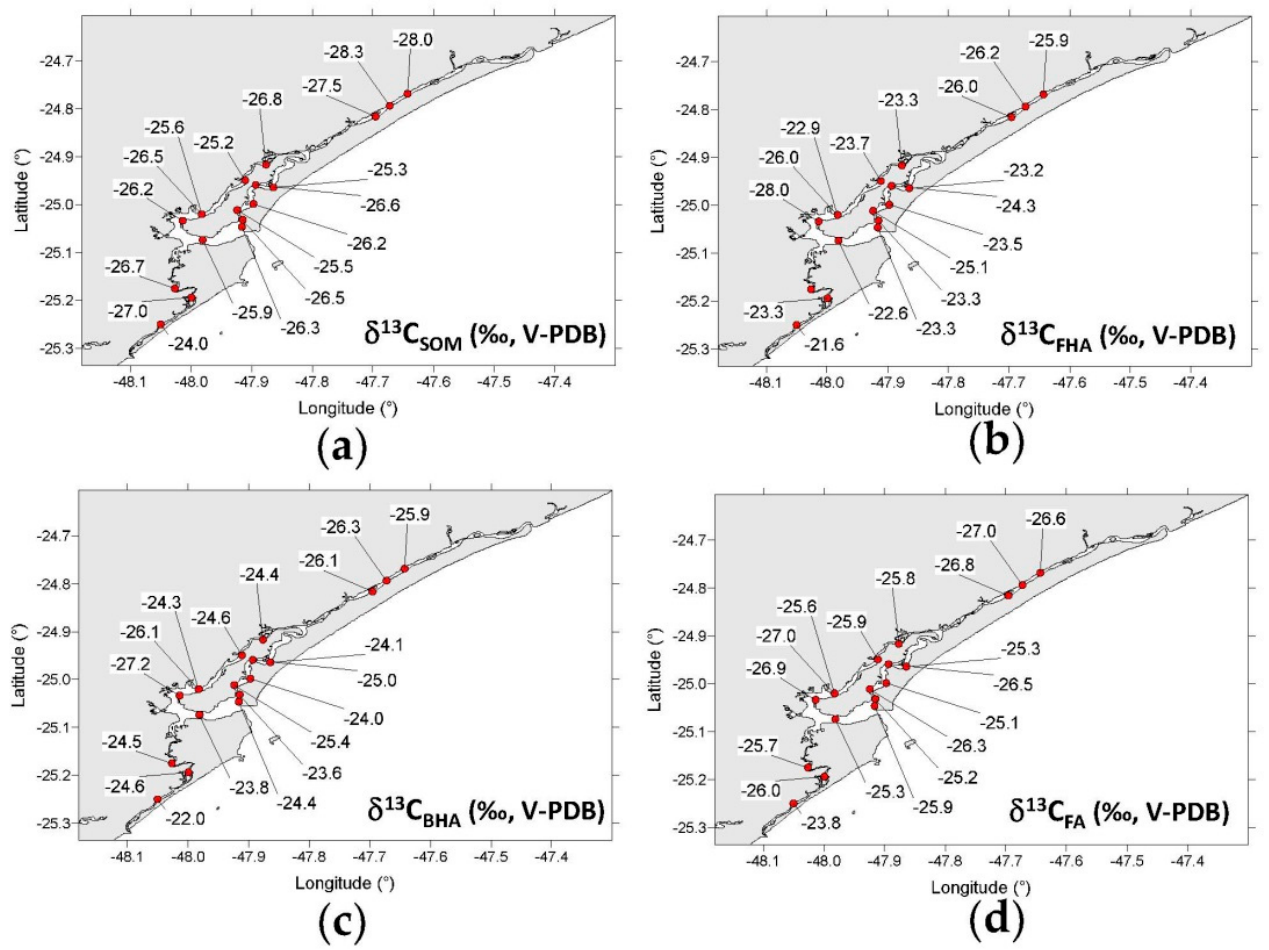
Figure 5. Spatial distribution of the δ 13 C values (‰ vs. V-PDB) of: ( a ) Sedimentary Organic Matter; ( b ) Free Humic Acids; ( c ) Bound Humic Acids; ( d ) Fulvic Acids.